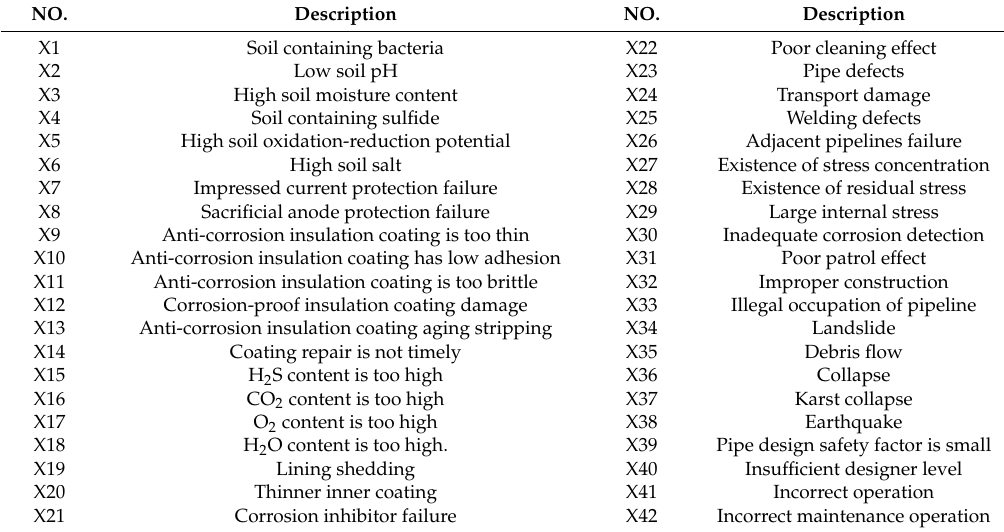
Table 3. Basic events of natural gas pipeline